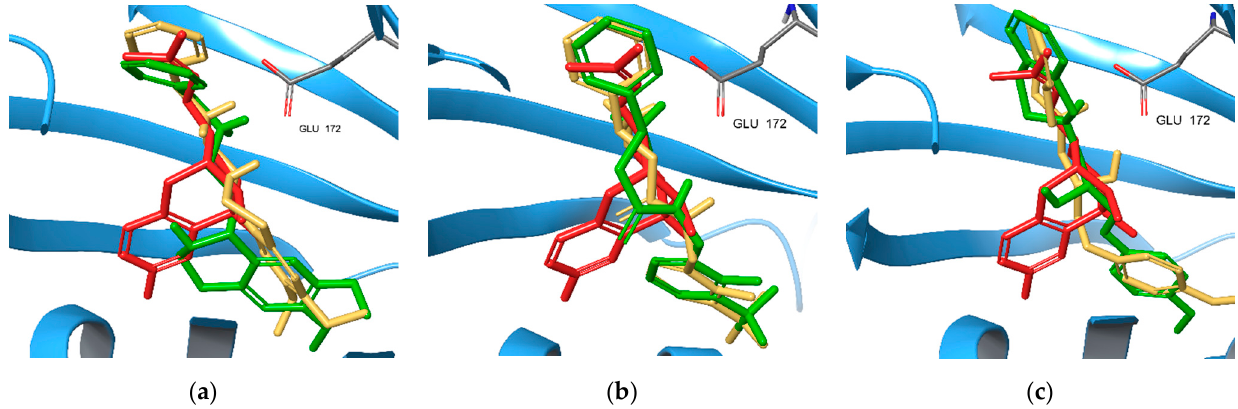
Figure 5. Comparison of the binding poses of the ( S ) (gold) and ( R ) (green) enantiomers of the highest ranked new S1R ligands ( a ) L1, ( b ) L2, and ( c ) L3. The binding pose of (+)-pentazocine (red) is also shown.